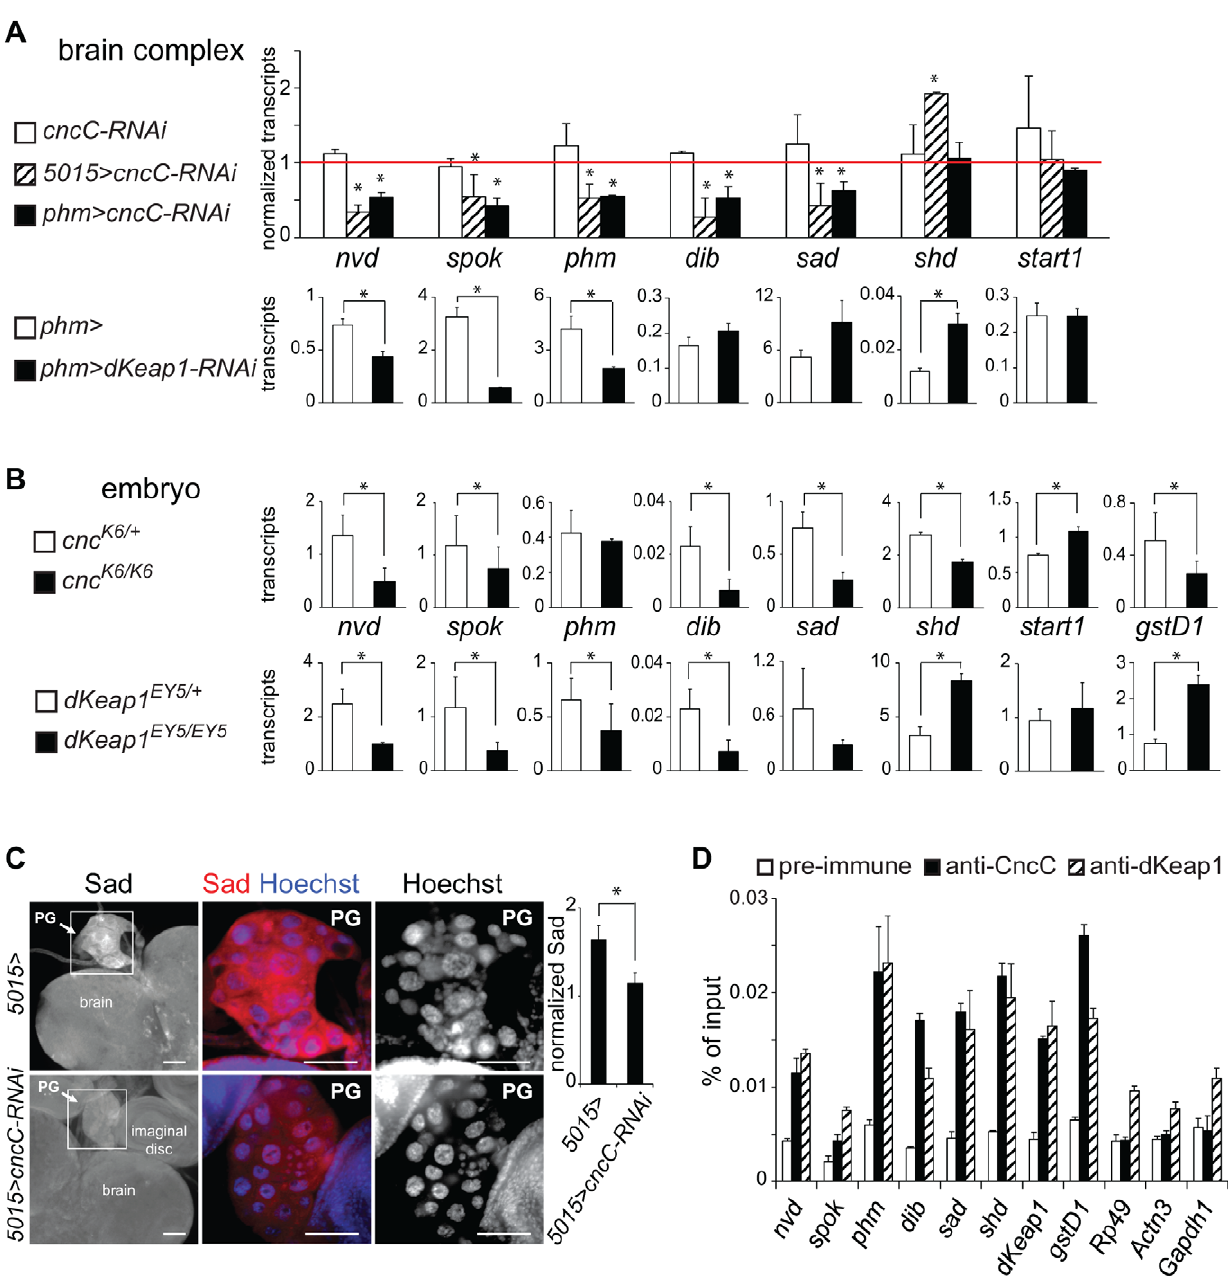
Figure 3. Regulation of ecdysone biosynthetic gene transcription by CncC and dKeap1. (A). Effects of CncC and dKeap1 depletion in the prothoracic gland on ecdysone biosynthetic gene transcription. [Upper graph] The transcripts indicated below the bars were measured in the brain complexes from early wandering 3 rd instar larvae that expressed the shRNA targeting CncC under the control of the 5015-GAL4 ( 5015 . cncC-RNAi , striped bar) or the phm-GAL4 ( phm . cncC-RNAi , solid bar) driver, and from larvae that lacked a GAL4 driver ( cncC-RNAi , open bar). To facilitate comparison, the transcript levels were normalized by the levels of the transcripts in control larvae ( 5015 . , phm . and w 1118 ). The data represent the means and standard deviations of the ratios of transcript levels between larvae that expressed the cncC-RNAi shRNA constructs and the corresponding control larvae from two independent experiments (*, p , 0.05). [Lower graphs] The transcripts indicated above the graphs were measured in the brain complexes from early wandering 3 rd instar larvae that expressed the shRNA targeting dKeap1 under the control of the phm- GAL4 ( phm . cncC-RNAi , solid bar) driver, and from control larvae ( phm . , open bar). The transcript levels were normalized by the levels of Rp49 transcripts divided by 100 and represent the means and standard deviations from two separate experiments (*, p , 0.05). (B). Effects of CncC and dKeap1 loss of function mutations on ecdysone biosynthetic gene and xenobiotic response gene transcription in late embryos. The transcripts indicated between the graphs were measured in heterozygous ( cnc K6/ + or dKeap1 EY5/ + , open bar) and homozygous ( cnc K6/K6 or dKeap1 EY5/EY5 , solid bar) stage 14–16 embryos. The transcript levels were normalized by the levels of Rp49 transcripts divided by 1000 and represent the means and standard deviations from two separate experiments (*, p , 0.05). (C). Effects of CncC depletion on PG morphology and Sad protein expression. The brain complexes of control larvae ( 5015 . ) and larvae that expressed the shRNA targeting CncC in the PG ( 5015 . cncC-RNAi ) were stained using anti- Sad (red) and Hoechst (blue). The ratio of Sad immunostaining in the PG relative to the brain is plotted in the graph to the right of the images (*, p , 0.05). (D). Analysis of CncC and dKeap1 occupancy at the promoter regions of ecdysone biosynthetic genes in late embryos. Chromatin isolated